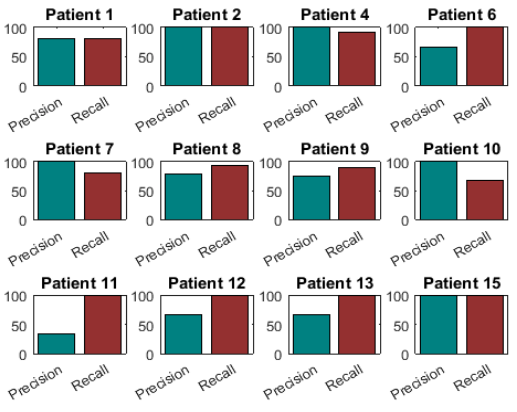
Figure 7. Precision-Recall diagrams of those patients who presented OFF states.